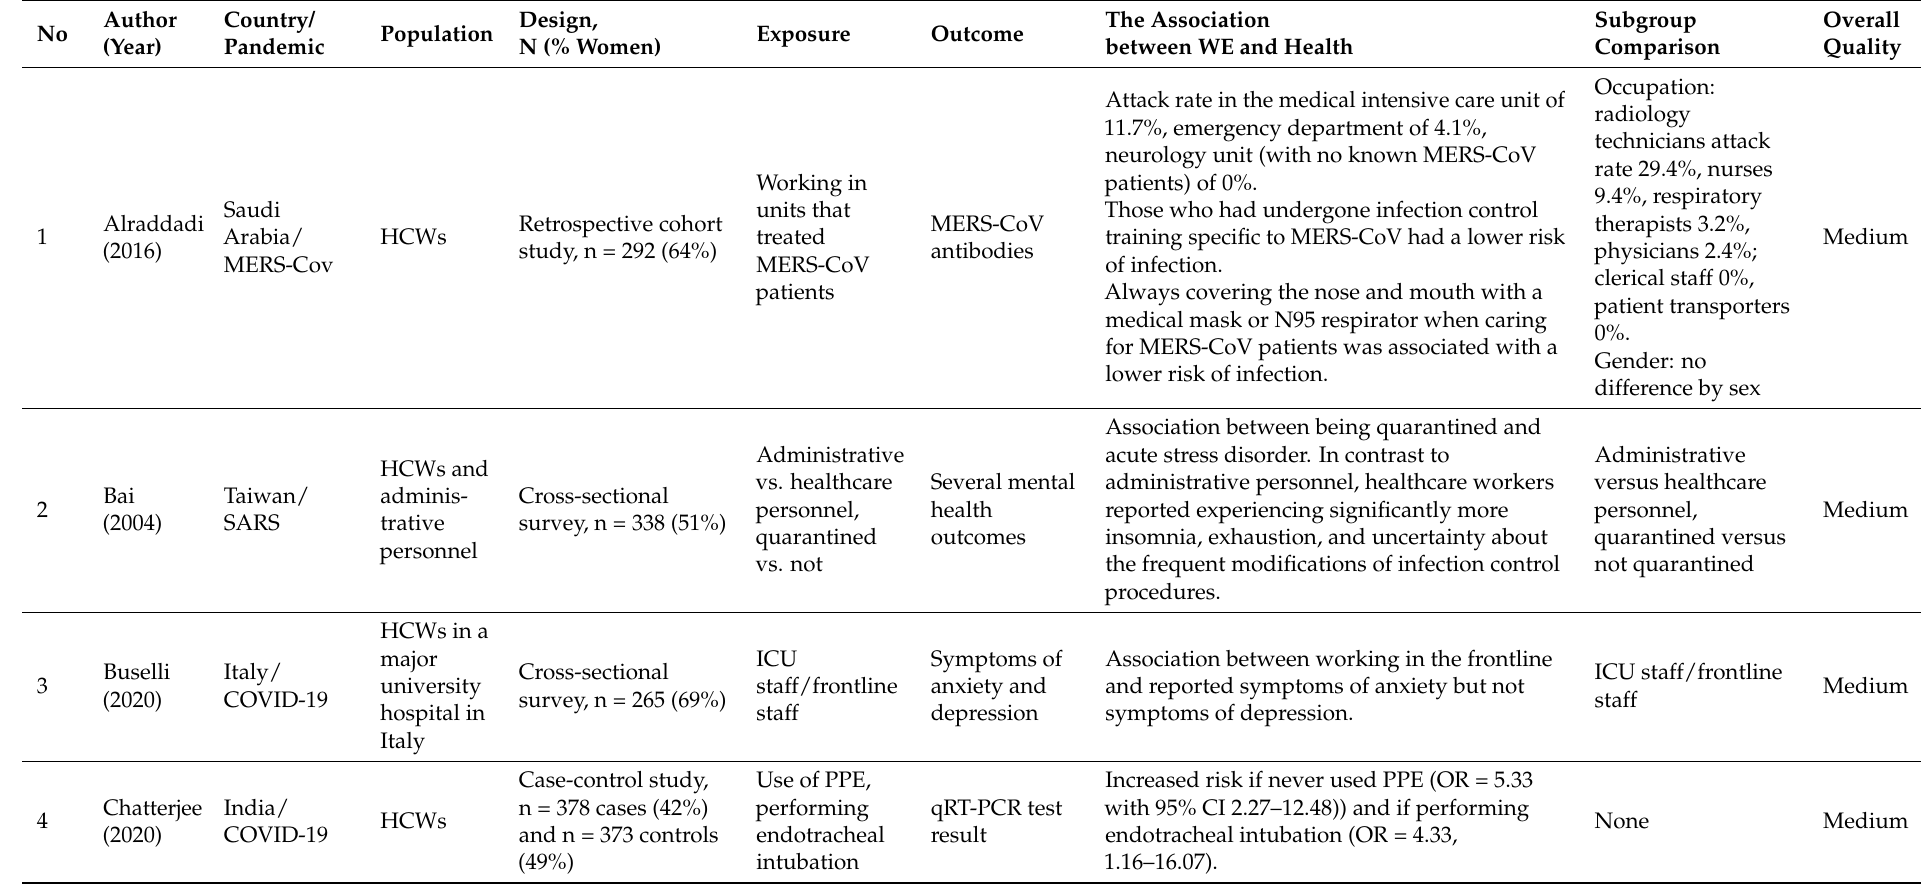
Table 2. Overview of quantitative studies assessing the associations between work environment factors and health (research question 2) in the healthcare industry during an epidemic or pandemic (COVID-19, SARS, or